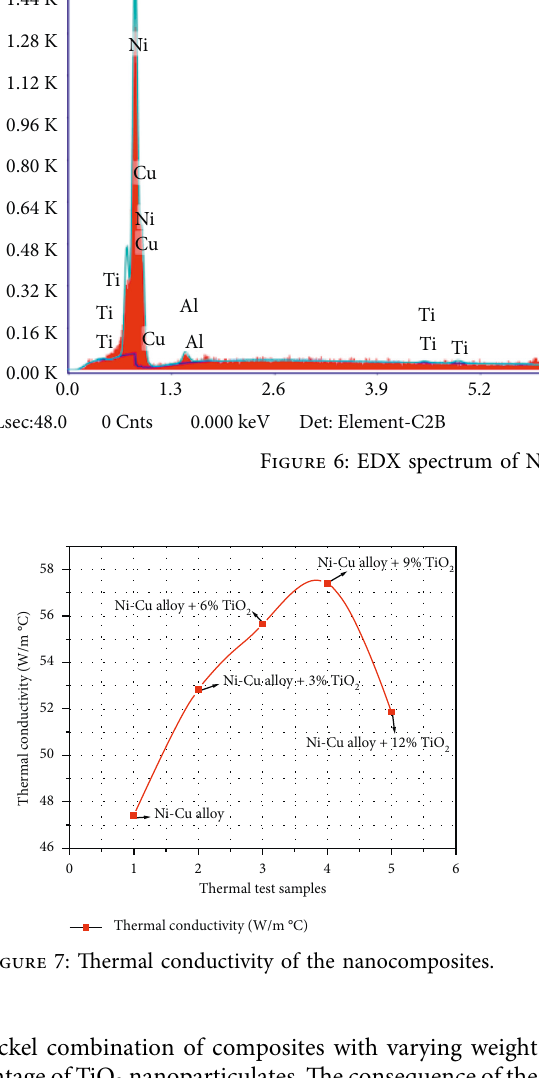
Figure 8: Thermal conductivity at different temperature.